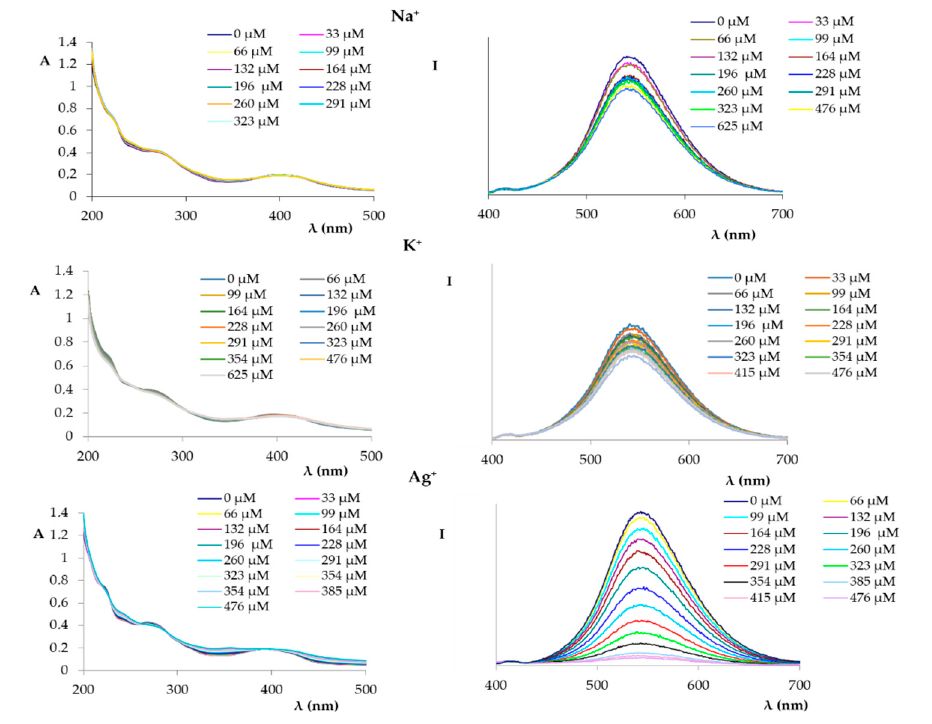
Figure 3. UV spectra ( left ) and fluorescence spectra ( right ) (excitation at 366 nm) of compound 1 (1.72 × 10 − 5 M in EtOH:phosphate buffer) titrated with an increasing amount of monovalent cations (1.0 × 10 − 2 M in phosphate buffer).